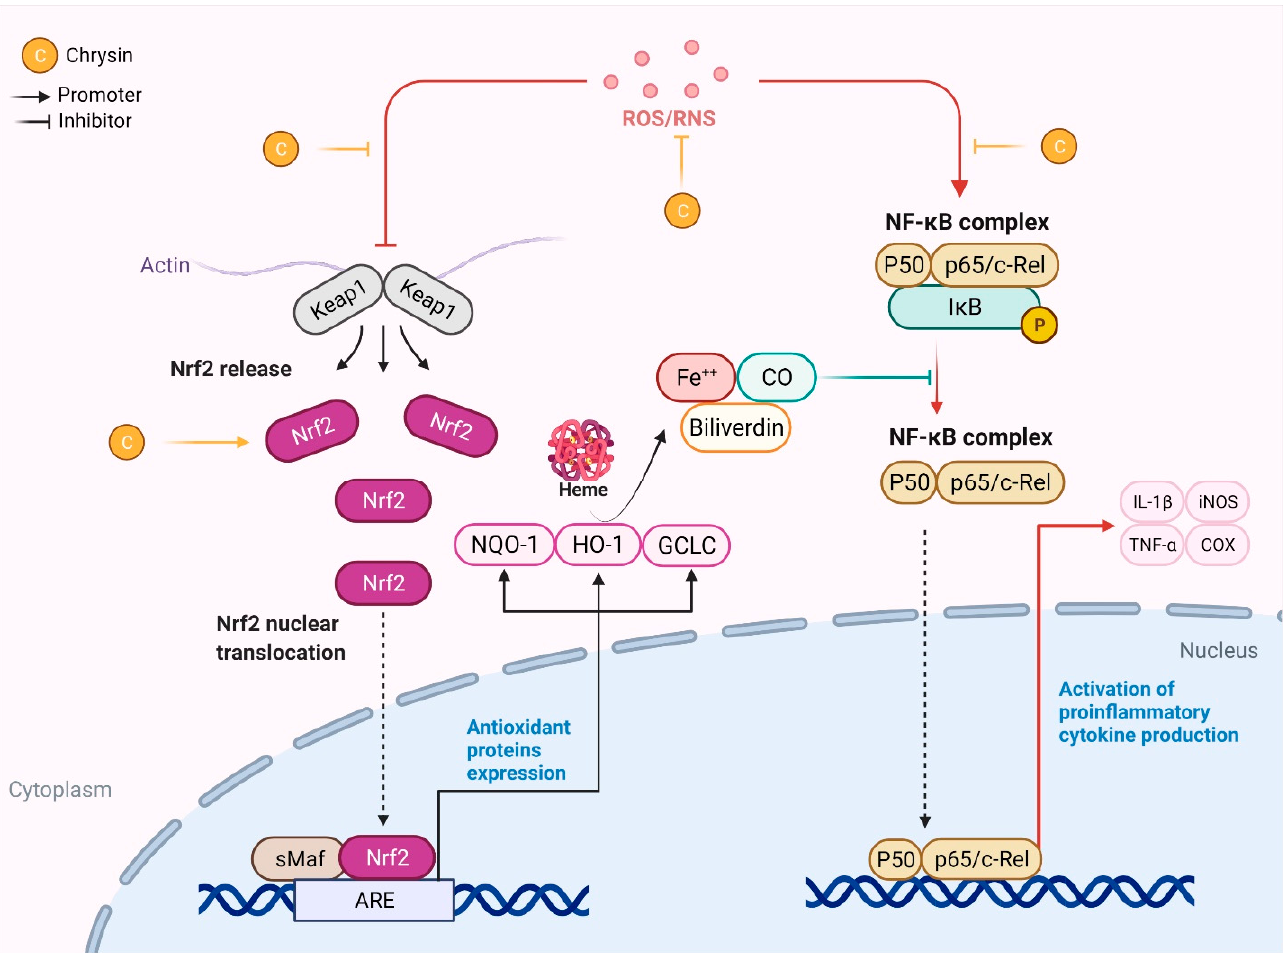
Figure 3. Modulation of the NRF-2 and NF- κ B pathway by chrysin. ROS/RNS mediate the alteration of NRF-2 signaling and interconnect with the NF- κ B signaling pathway. NRF-2 signaling activates the expression of antoxidant proteins viz, heme oxygenase-1 (HO-1), NAD(P)H quinone oxidoreductase 1 (NQO-1) and Glutamate-cysteine ligase catalytic subunit (GCLC, a rate-limiting enzyme for glutathione synthesis). The degradation of heme produces carbon monoxide (CO), which suppresses redox-sensitive NF- κ B activation. The plausible sites of action of chrysin are